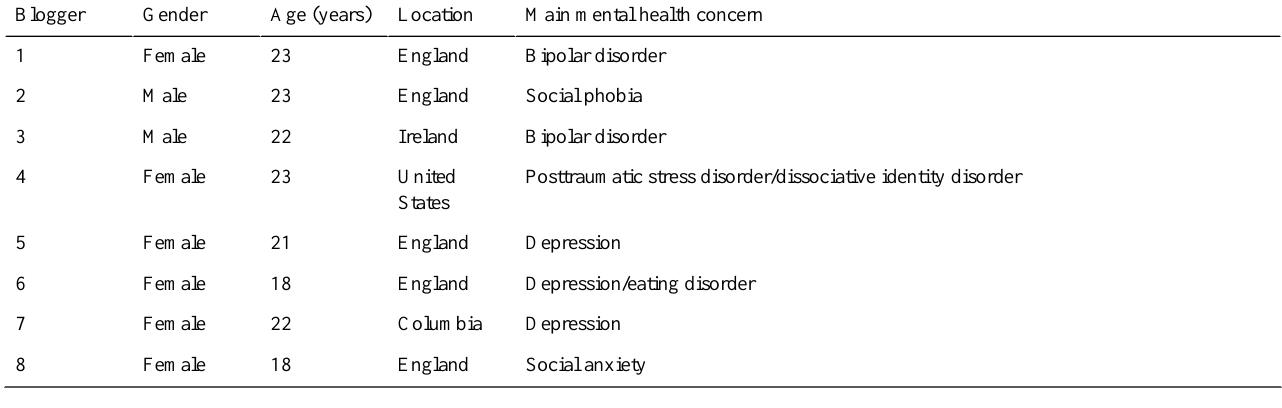
Table 1. Sample characteristics of bloggers